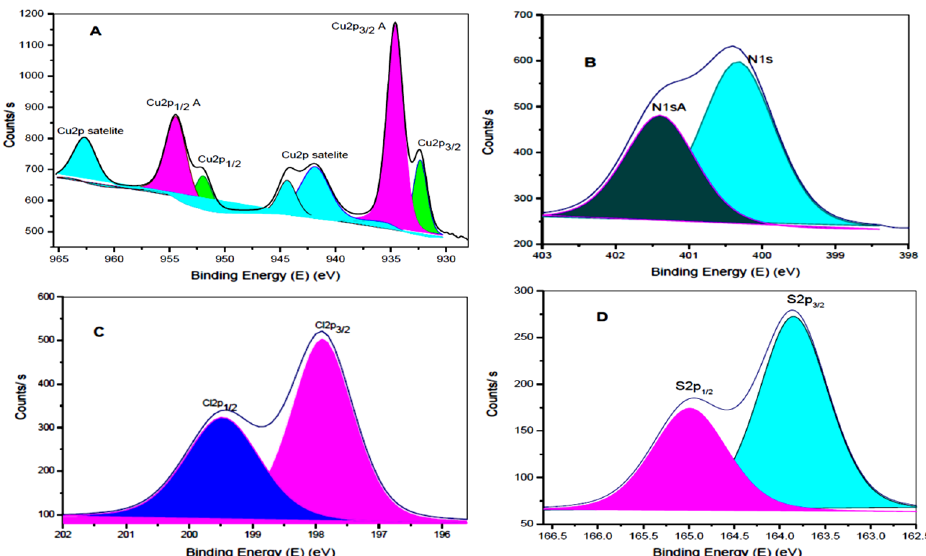
Figure 7. XPS diagram showing binding energy peaks for: ( A ) copper(II) ion in the complex as: Cu2p 1/2 A, Cu2p 3/2 A (magenta color), Cu2p 1/2 , Cu2p 3/2 (green color), and Cu2p satellites (cyan color), ( B ) N1s (cyan color), N1sA (dark cyan color), ( C ) Cl2p 3/2 (magenta color), Cl2p 1/2 (blue color), and ( D ) S2p 1/2 (magenta color), and S2p 3/2 (cyan color).